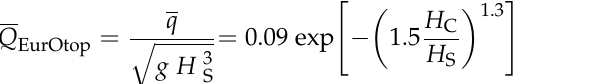
where q ̅ is the average overtopping flow (m 3 /s/m) — value obtained experimentally or nu- merically, g is the gravitational acceleration (m/s 2 ), H S is the significant wave height, H C is the height from the mean water level (MWL) to the highest point of the one ramp.